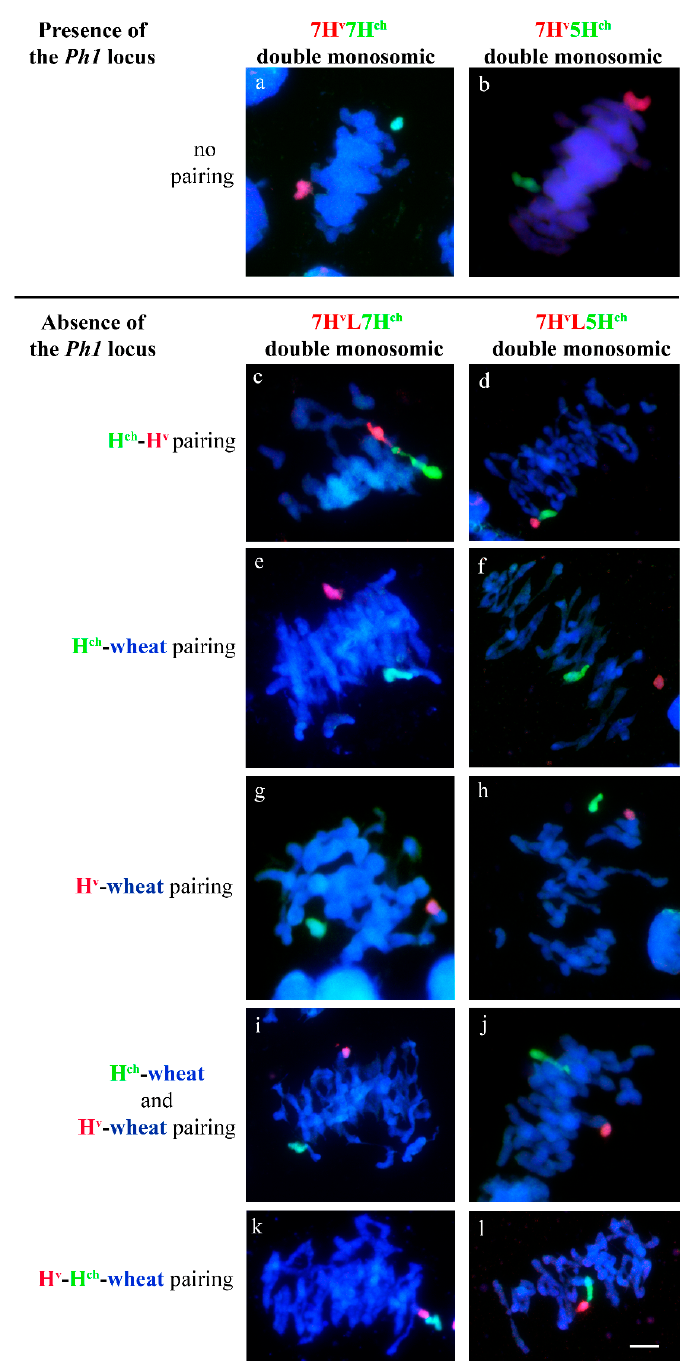
Figure 3. Interspecific chromosome associations during meiosis metaphase I between H. vulgare , H. chilense , and wheat in double monosomic addition lines in the presence and the absence of the Ph1 locus. Hordeum chilense and H. vulgare were visualized in green and red, respectively. DNA was counterstained with DAPI (blue). ( a , b ) 7H v 7H ch and 7H v 5H ch barley chromosomes did not associate in the presence of Ph1 locus. ( c , d ) H ch -H v associations in both wheat lines in the ph1b mutant background. ( e , f ) H ch -wheat associations in the absence of the Ph1 locus. ( g , h ) H v -wheat pairing in the absence of Ph1 locus. ( i , j ) Double H ch -wheat and H v -wheat pairing in wheat in the ph1b mutant background. ( k , l ) Tripartite chromosome associations in both lines in absence of the Ph1 locus. Bar: 10 µ